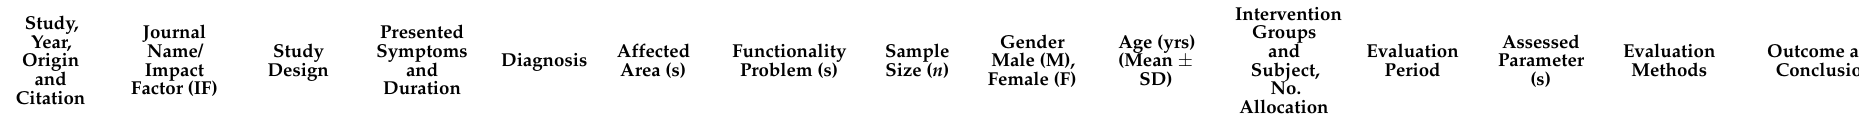
Table 2. Tabular description of all the selected eligible of vivo RCTs human studies, summarising the demography, study design, symptoms, diagnostic criteria, functional problems, affected areas, intervention groups, methods of assessment, evaluation period and outcomes. Abbreviation: RCTs: randomized controlled trials, SB: Single-blind; DB: double-blind; ADH: anxiety and depression scale, OHIP-14: oral health impact profile; VNS: visual numeric scale; VAS: visual analogue scale; PPI: present pain intensity scale; NRS: numerical rating scale; HADS, hospital anxiety–depression scale; PGI-I, patient global impression of improvement; ELISA: enzyme-linked immunosorbent assay; GDS: geriatric depression scale; BMS: